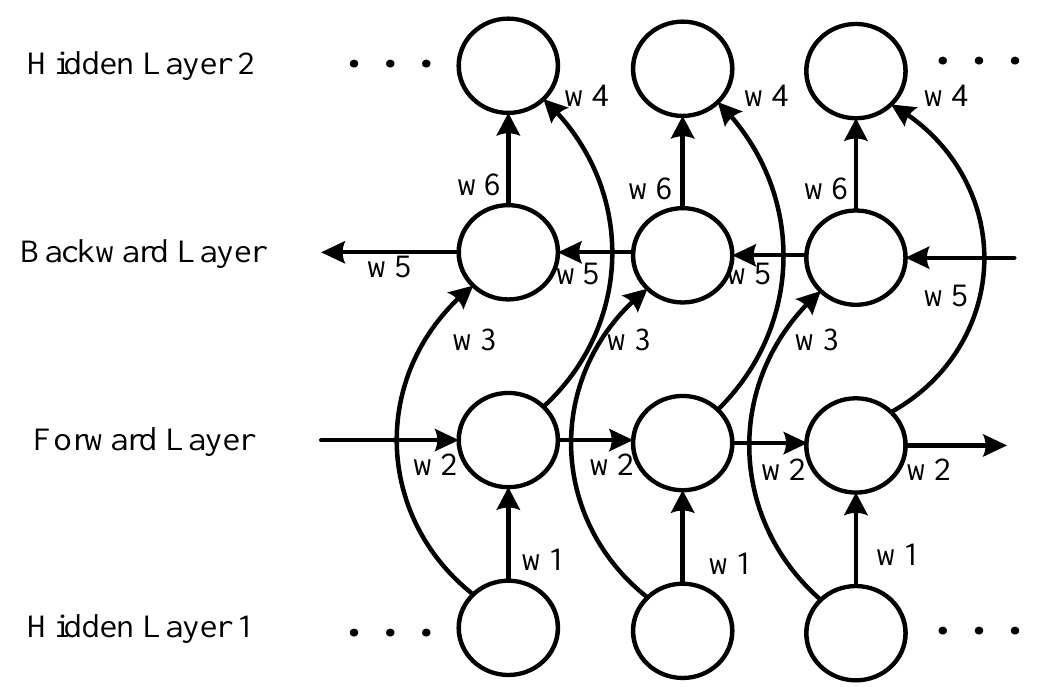
Figure 6. BI-RNN weight relationship diagram.